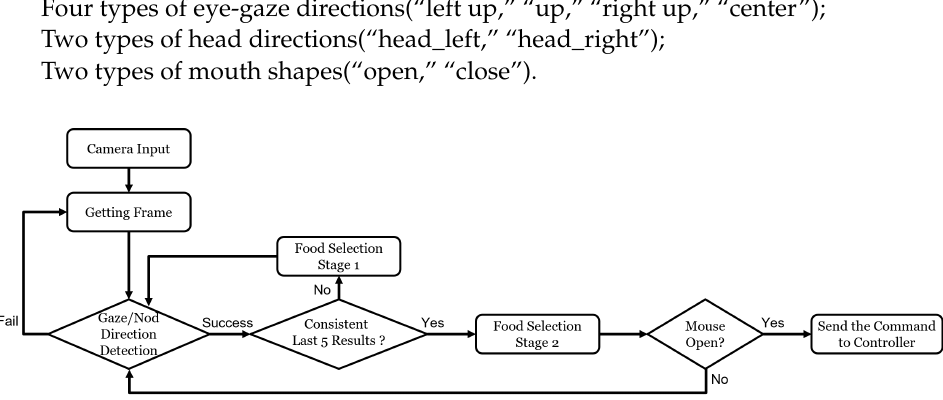
Figure 9. The flowchart for the user interface based on face recognition. The real-time recognition result from the user’s face motion input is highlighted in blue on the tablet interface screen at food selection stage 1. If the same results are obtained more than five times consecutively, it goes to food selection stage 2 and changes to a red highlight. When the food displayed in red matches what the user wants, the user can confirm the selection using an “open” command. In that case, the color changes to green, and an acquisition command is sent to the robot to serve the